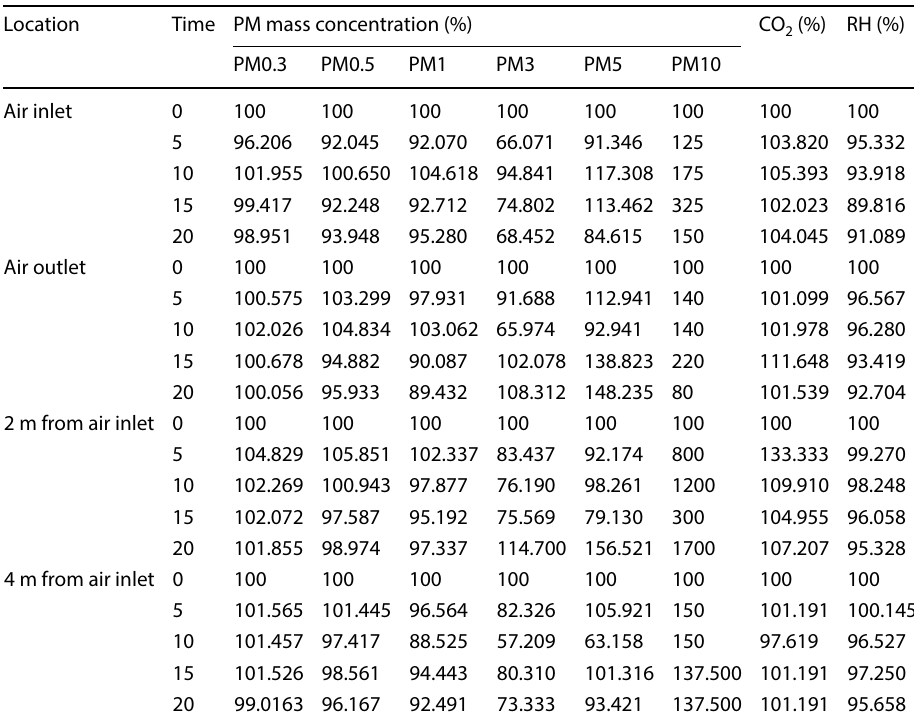
Table 2 The percentage differences in PM concentration, CO 2 , and Relative humidity of semi- outdoor air when compared to 0